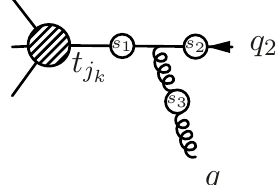
Figure 7 . Diagram with a single collinear emission in direction j . The insertions s k show possible attachments of the soft line. The part of the diagram in direction i is not